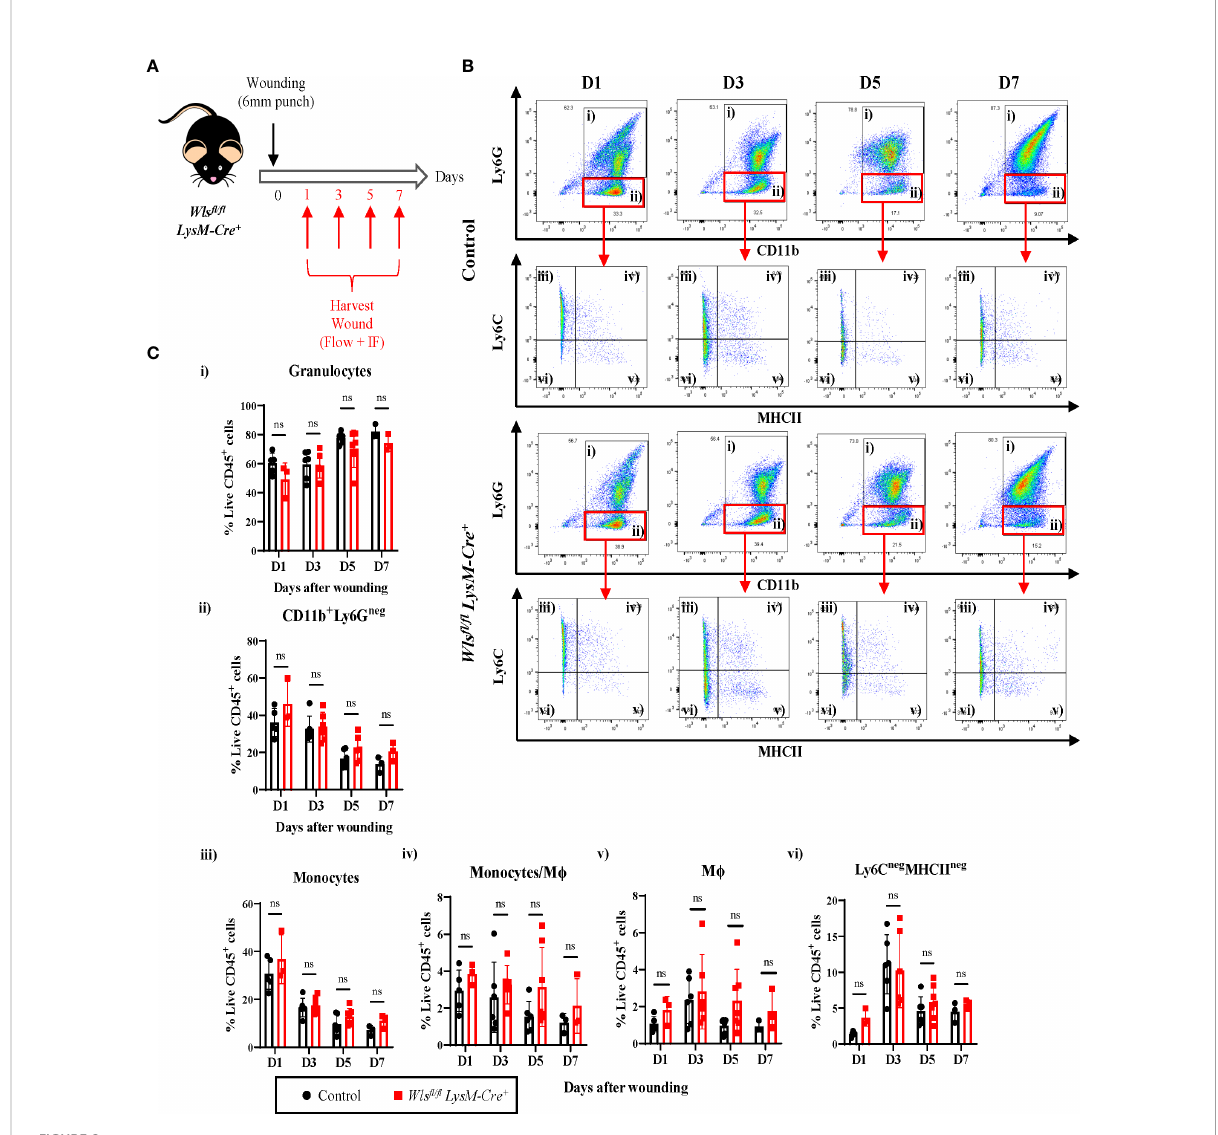
FIGURE 2 In fl ammatory response in Wls fl / fl LysM-Cre + mice remain unperturbed after wounding. (A) Schematic of the experimental timeline demonstrating the Wls fl / fl LysM-Cre wound healing time course. Two 6mm wounds were created on the murine dorsal skin using punch biopsy at day 0. Granulation tissues were collected at day 1, 3, 5, and 7 for fl ow cytometry and immuno fl uorescence analysis. (B) Representative fl ow plots showing the gating strategy used to identi fi ed granulocytes (gate i), CD11b + Ly6G neg (gate ii) cells which are further subdivided into monocytes (gate iii), monocyte/M f (gate iv), M f (gate v) and Ly6C neg MHCII neg cells (gate vi). (C) Flow cytometry analysis comparing granulation of Wls fl / fl LysM-Cre + and Wls fl / fl LysM-Cre neg mice enriched in (i) granulocytes and (ii) CD11b + Ly6G neg myeloid cells, (iii) monocytes, (iv) monocytes/M f , (v) M f , and (vi) Ly6C neg MHCII neg cells at all time points post wounding. Highest number of monocytes were recorded at day 1 and its percentage reduces progressively between day 3 and day 7. Monocytes/M f peaked at day 3. Wls fl / fl LysM-Cre + has slightly higher percentage of M f at day 5 (p = 0.08). Ly6C neg MHCII neg peaked at day 3 during the in fl ammatory stage of the wound healing with no difference seen between the Wls fl / fl LysM-Cre + and Wls fl / fl LysM-Cre neg mice. Data are represented as mean ± SD. Statistical analysis was performed using unpaired Student t-tests. ns, not signi fi cant. Data are representative of 3-4 individual animal samples per time